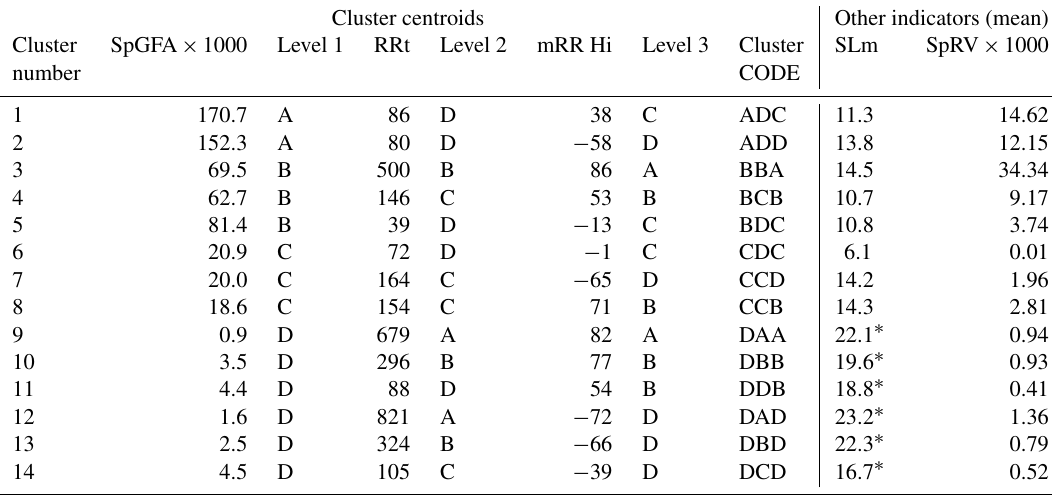
Table 8. Cluster centroids and their levels. Organised from A (max) to D ( min ) according to Table 7. Cluster centroids